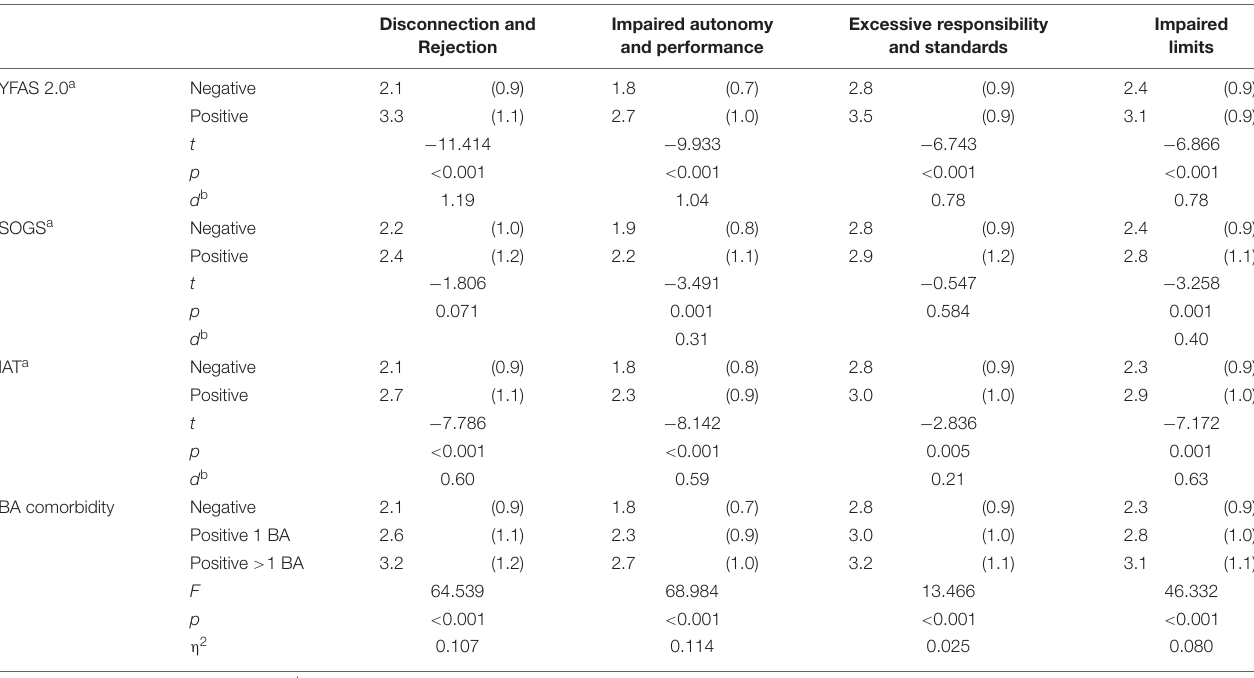
TABLE 2 | Comparison between behavioral addictions and YSQ-S3 domains.